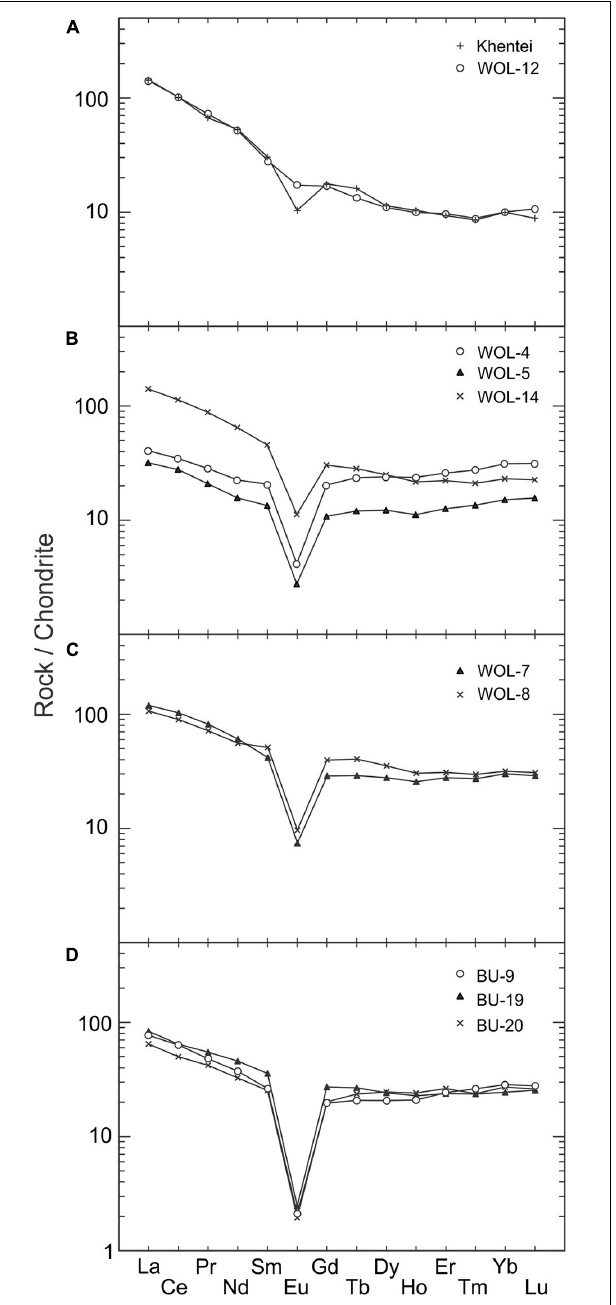
FIGURE 9 | Chondrite-normalized rare-earth element diagrams for (A) phase 1 TP granite (WOL-12) and the average of granitic rocks of the Khentei batholith (Yarmolyuk et al., 2013); (B) phase 2 TP granites (WOL-14 typical biotite granite; WOL-4 and 5-altered leucogranites); (C) TP strongly altered granites; and (D) granites of the Bayan-Ulan pluton. Normalizing values are after Sun and McDonough